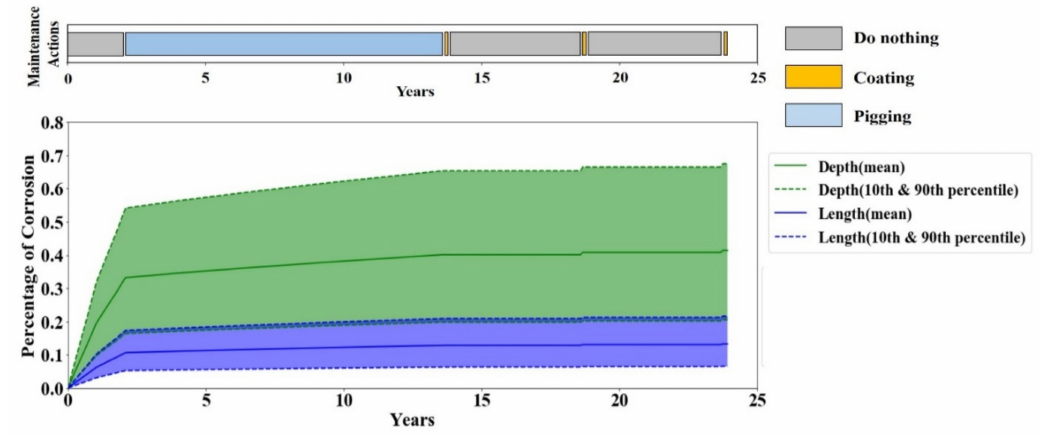
Figure 13. Corrosion depth and length in one full life evaluation episode for sensitivity scenario